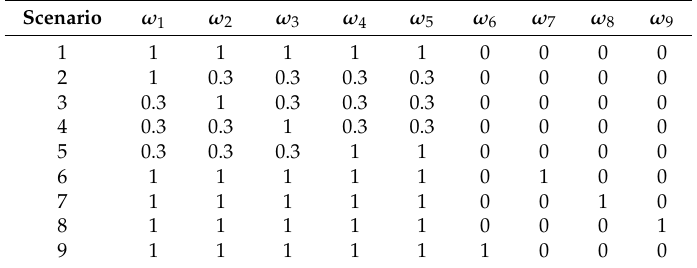
Table 3. Different proposed scenarios with weights of each component of the fitness function.